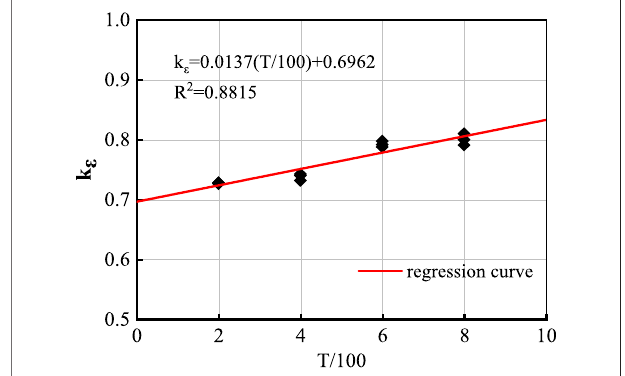
FIGURE 10 | Regression curve of the ef fi ciency factor. k ε